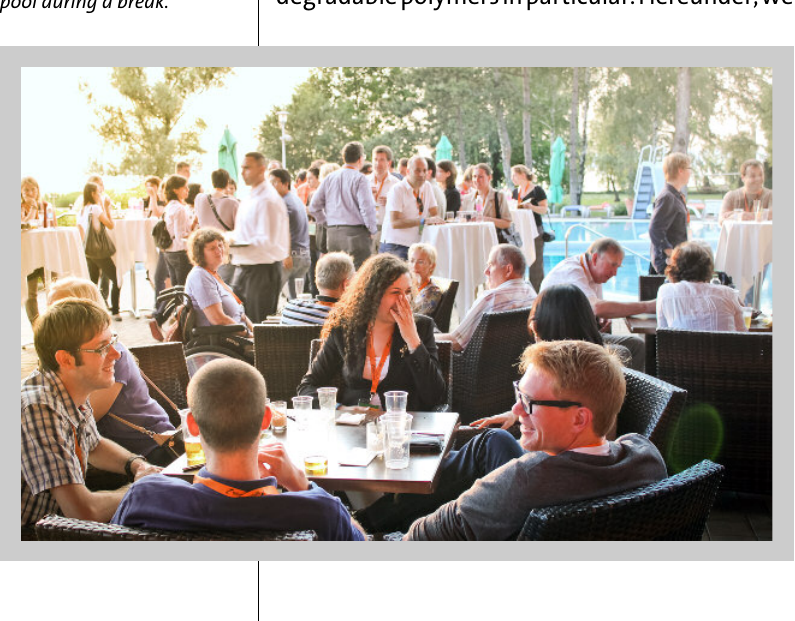
Figure 1: Participants outside at the pool during a